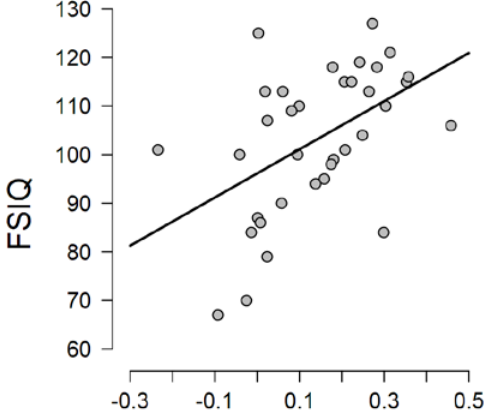
Figure 5. Correlation plot between full scale IQ (FSIQ) and relative alpha reactivity.